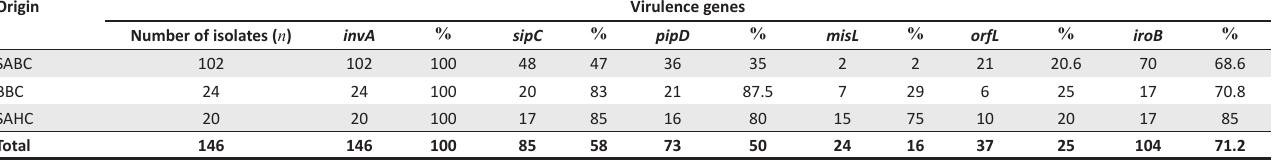
TABLE 4: Prevalence of virulence genes in Salmonella isolates from three different origins.